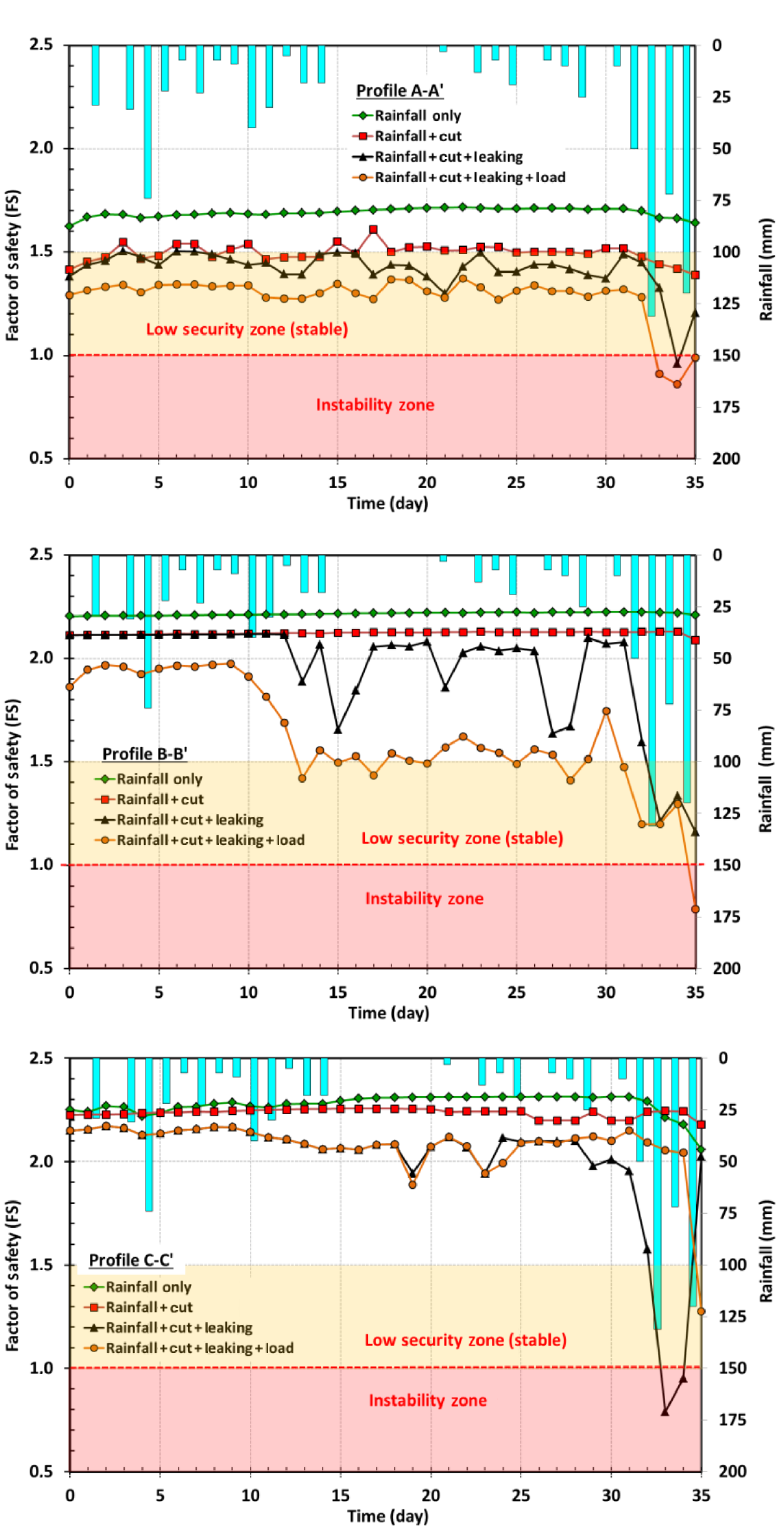
Figure 10. Time variation of the slope safety factor for natural conditions and taking into account the additional effects introduced by anthropic disturbances on profiles A–A (cid:48) , B–B (cid:48) and C–C (cid:48)